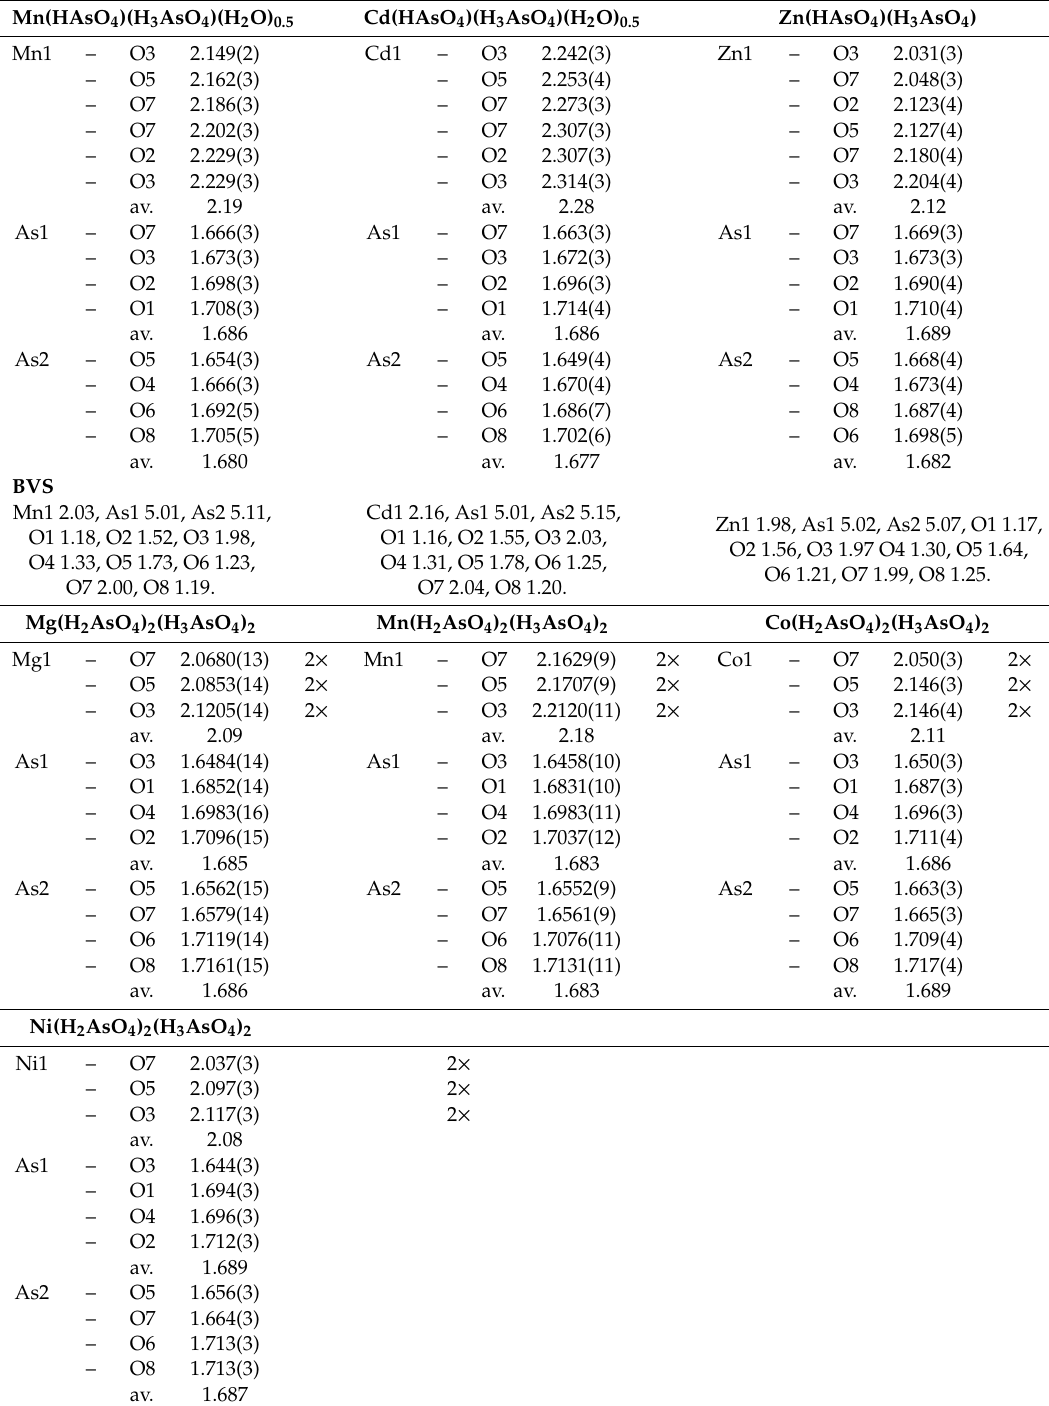
Table 1. Selected bond lengths / Å, angles / ◦ with estimated standard deviations in parentheses, and bond valence parameters (BVS) / valence units. Averaged values (av.) are given in the last line of each column. Mn(HAsO 4 )(H 3 AsO 4 )(H 2 O)